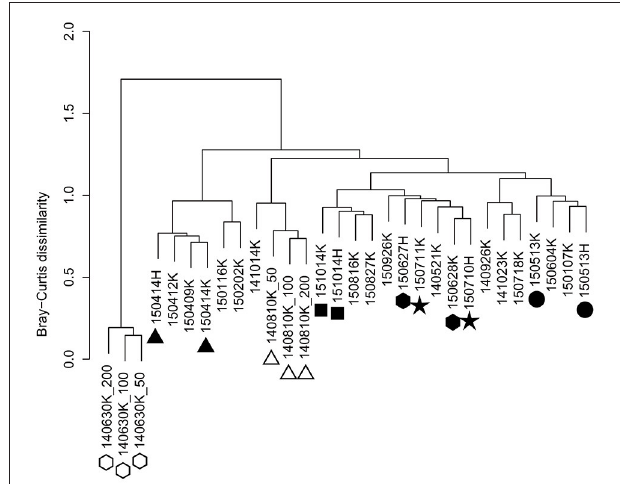
FIGURE 2 | Hierarchical clustering of precipitation samples based on OTU composition. The distance matrix was calculated based on the Bray-Curtis dissimilarity, and clusters were calculated using Ward’s method. Open symbols indicate samples that were collected during the same precipitation event with different volumes. Closed symbols indicate samples that were collected on the same day at different sites (Kashiwa and